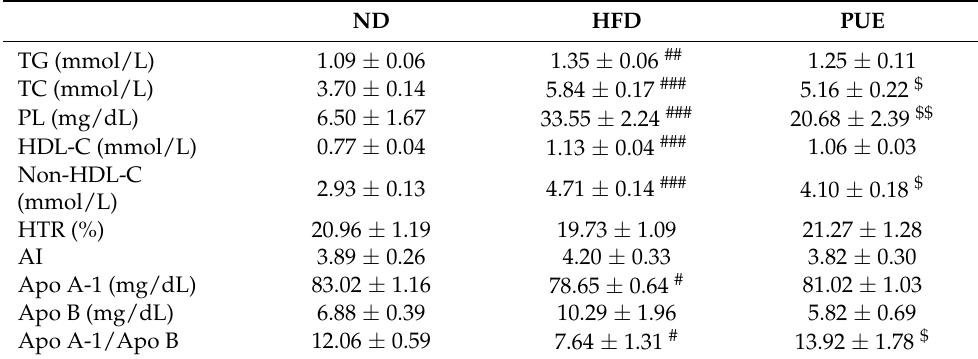
Table 1. Effect of 12 weeks of Phlomis umbrosa root extract treatment on plasma lipid profiles in DIO mice.